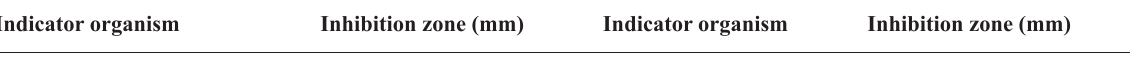
Antimicrobial activity spectrum of BLS P34 against planktonic cells of Staphylococcus aureus and Enterococcus faecalis at 37ºC.